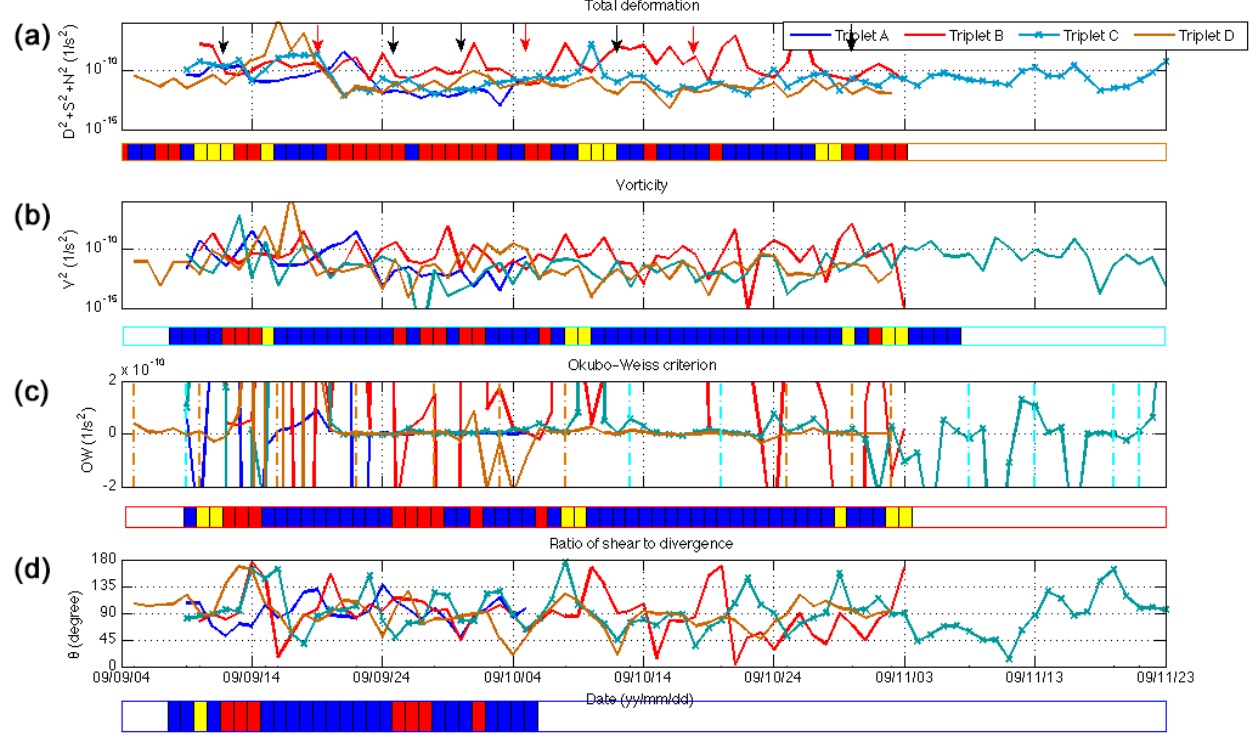
Figure 12. Relative sea ice deformation. Time series of relative sea ice deformation for triplets A to D, including the total deformation (D 2 + S 2 + N 2 ) , vorticity (V 2 ) , Okubo–Weiss criterion capturing relative contributions of deformation and vorticity (with OW > 0 indicating deformation-dominated flow and OW < 0 indicating flow dominated by vorticity) and θ , the arctan of the shear-to-divergence ratio, to further distinguish deformation between strain states as well as shear and divergence-dominated regimes. Enhanced vorticity is observed during low ice concentration regimes, as demonstrated in comparatively high values for triplet D near 18 September and for triplet B in late October/early November. Intervals of divergence and deformation-dominated flow prevail for triplet B, with some instances observed for triplet A, C, and D again in the early stages of evolution. The Okubo–Weiss criterion results in particular show enhanced distortion in the (bounded) ice cover closest to the coastline, especially following the 8 October SLP maximum. Theta values illustrate changes in the ice strength due to relative contributions from divergence and the total strain rate ( S 2 + N 2 ). Noteworthy are the high ( ∼ 180) values during e 2, e 7, and following e 5, indicating convergence associated with offshore ice drift due to Ekman convergence and sea ice deformation associated with along- and across-shear